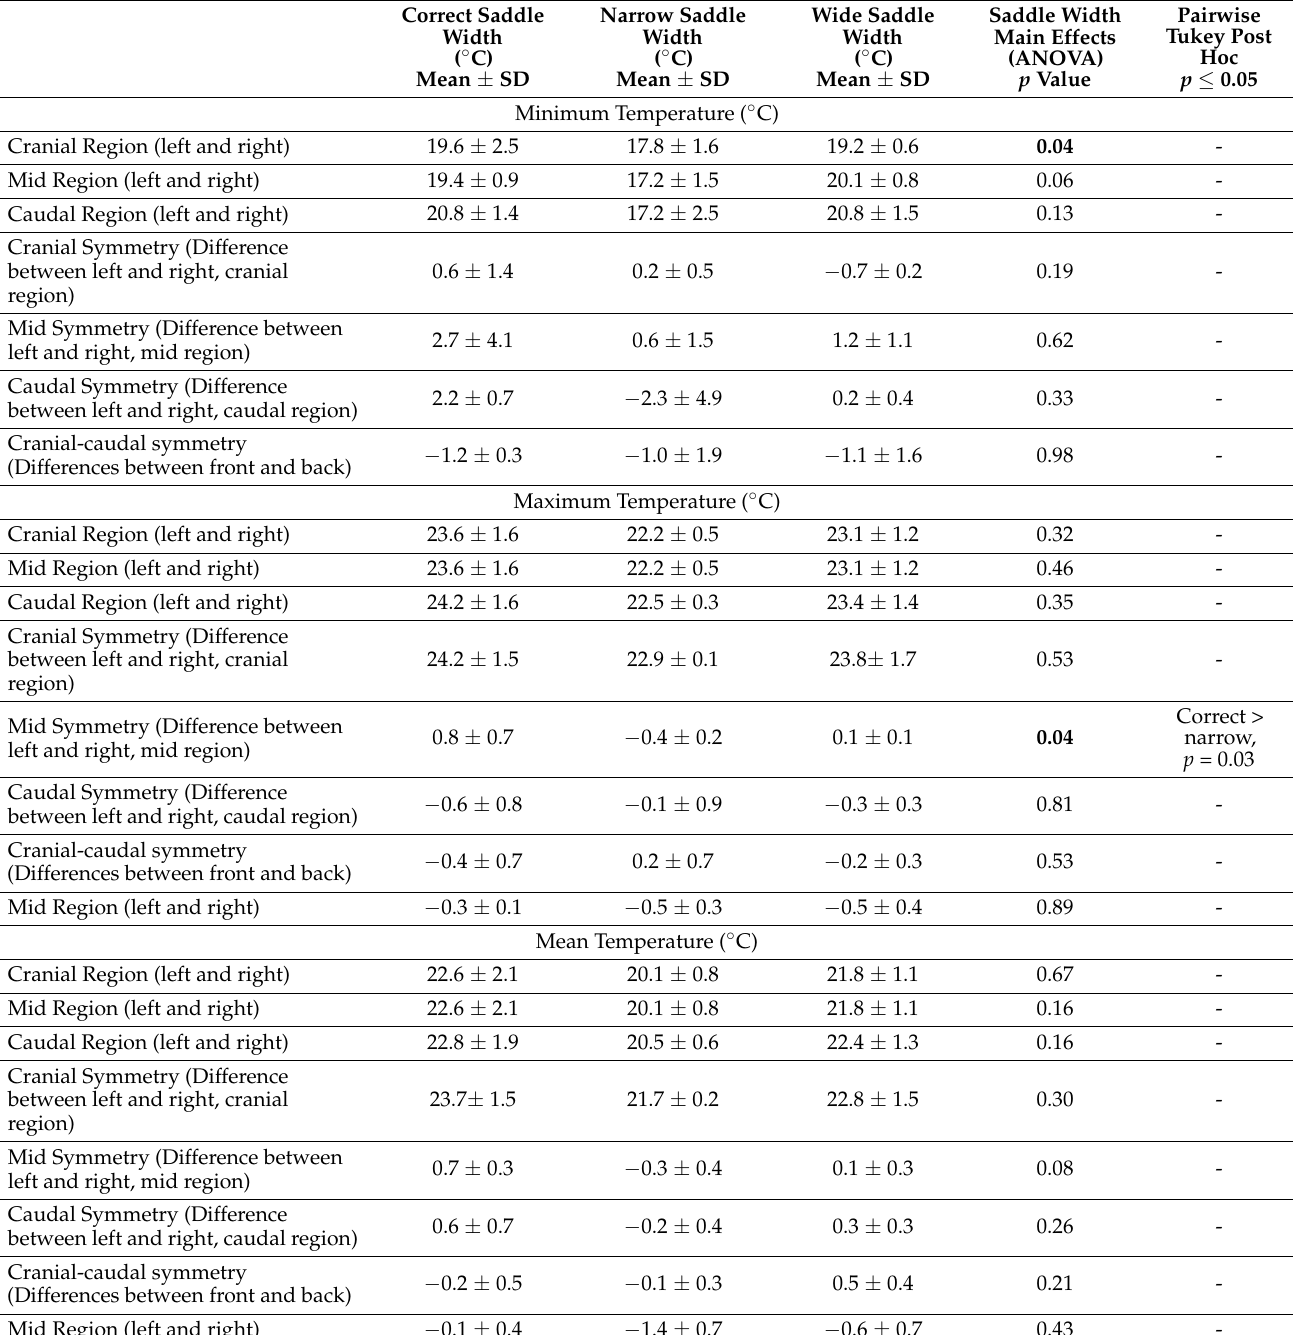
Table 2. Minimum, maximum and mean thermal temperatures of the underside of the saddle.